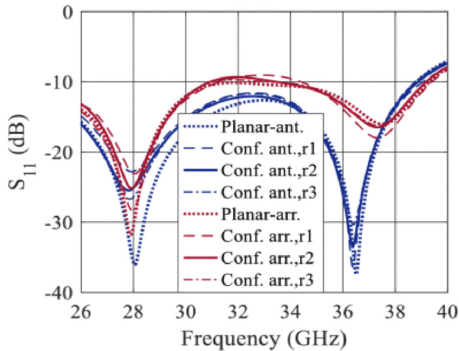
Figure 19. Comparative return loss of planar vs. conformal antenna configuration along the = 6 mm, r = 8 mm, and r = 10 mm cylindrical surface of radii, (cid:1870) (cid:2869) = 6 mm, (cid:1870) (cid:2870) = 8 mm, and (cid:1870) (cid:2871) = 10 mm [82]. surface of radii, r 1 2 3